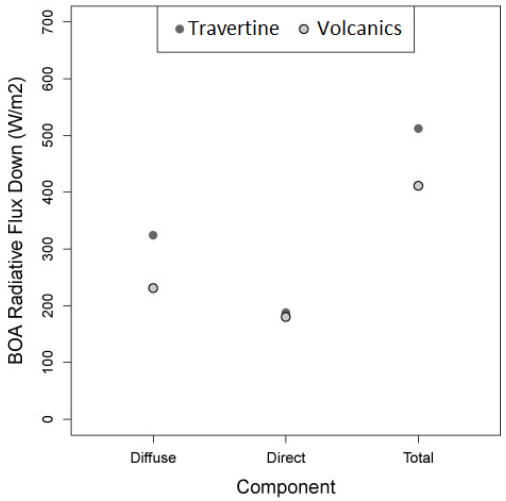
Figure 9. Diffuse, direct, and total BOA downward radiative flux (Wm − 2 ) over the 250–4000nm spectral domain, simulated by the 6SV